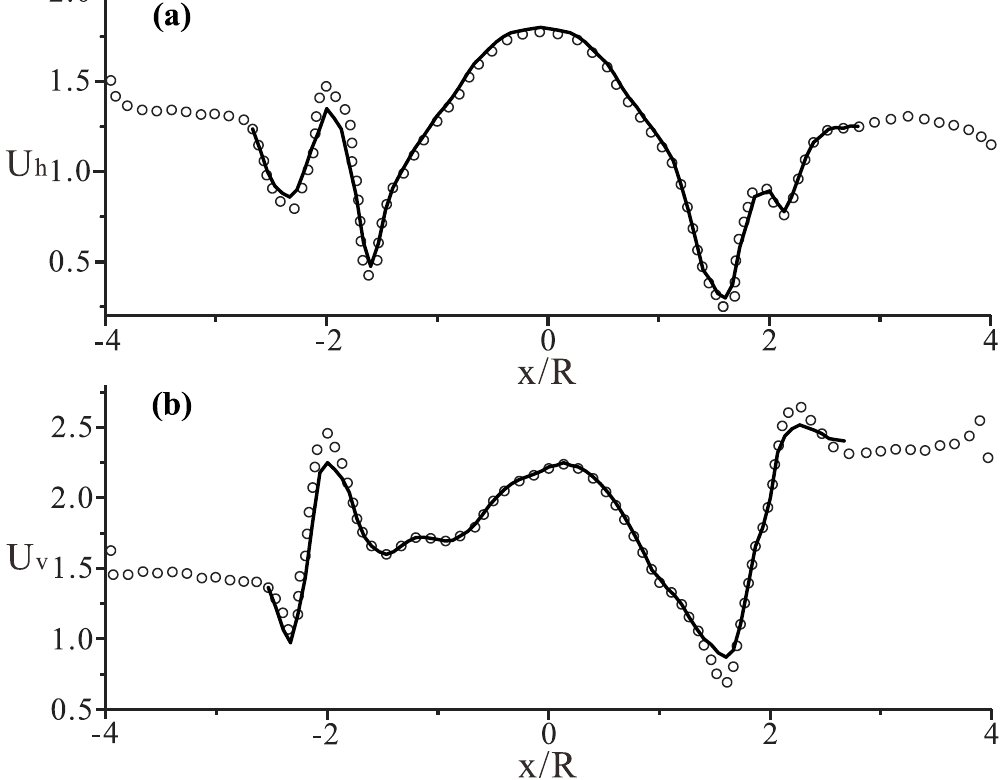
Figure 13. Displacement amplification ratios of ground under incident P-waves with angle of 30°: ( a ) horizontal ratios and ( b ) vertical ratios (solid lines are analytical solutions by Wong [60] and circles are numerical results of finite element method based on ABAQUS).